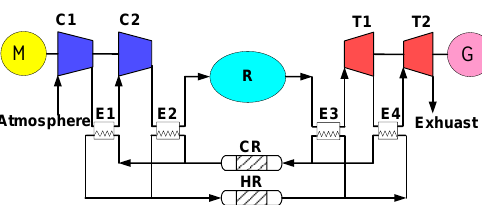
Figure 7. Schematic diagram of AA-CAES system with a low-temperature thermal storage (C— Compressor, T—Turbine, G—Generator, M—Motor, R—Reservoir, HR—Thermal storage, CR—Low-temperature thermal storage, E—Heat Exchanger) [32].